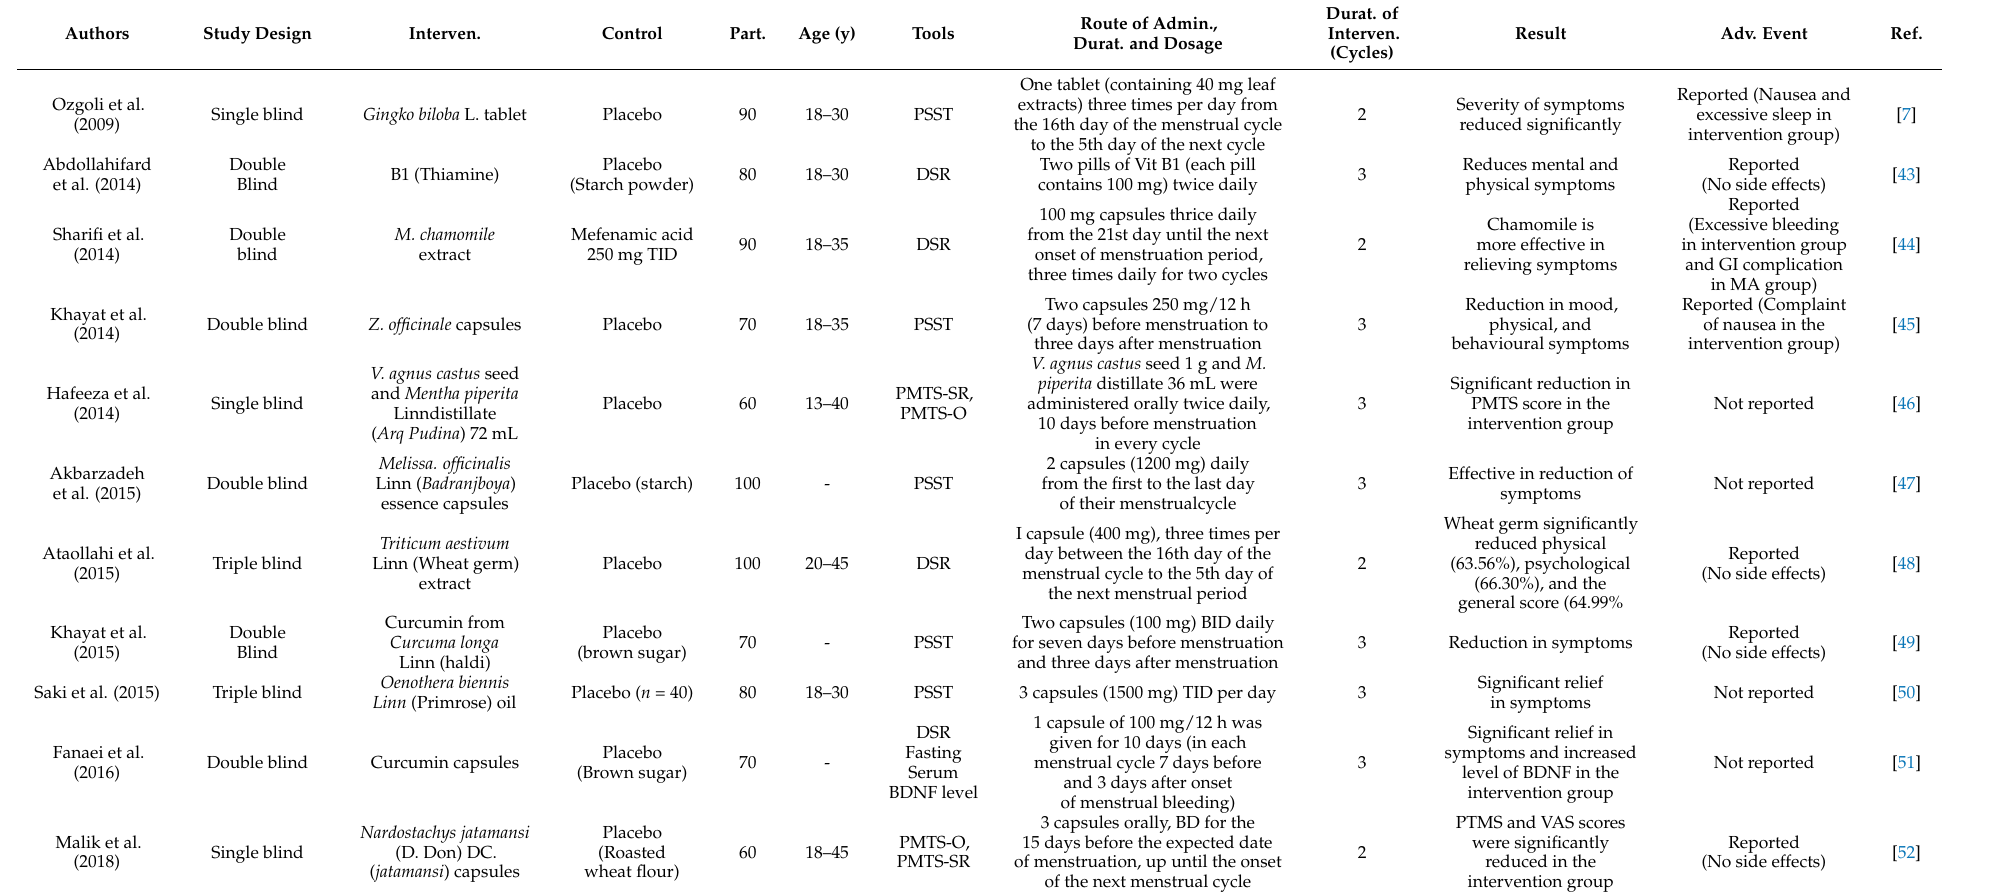
Table 1. The features of the published RCTs on nutritional supplements and herbal